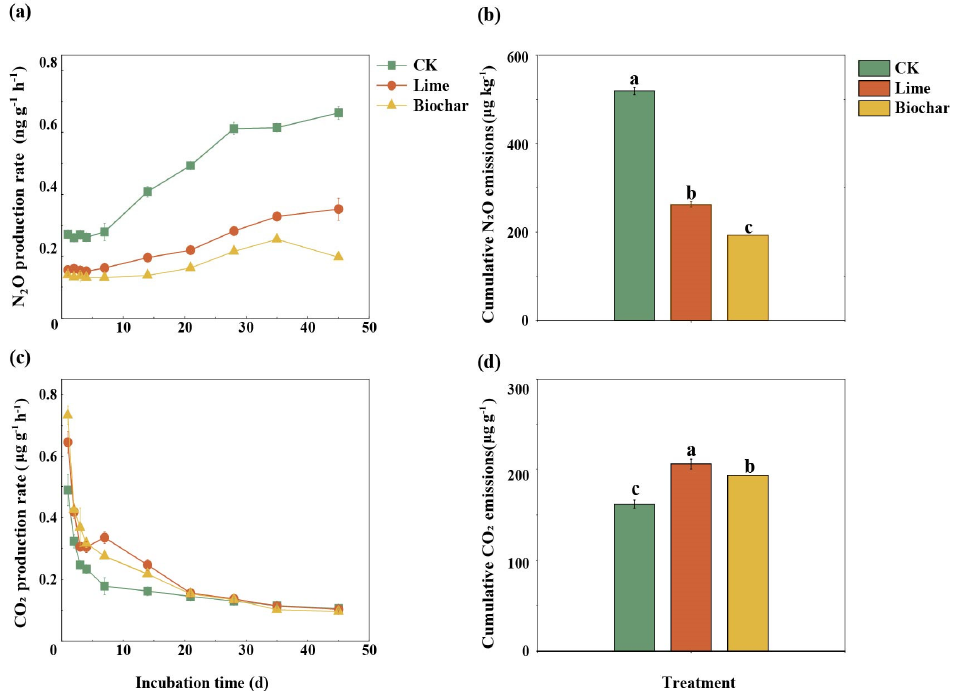
Figure 2. N 2 O ( a ) and CO 2 ( c ) emission rate and cumulative N 2 O ( b ) and CO 2 ( d ) emissions during the 45 − day incubation period for CK, lime, and biochar treatments. Error bars indicate standard deviations ( n = 3). Means followed by di ff erent le tt ers indicate signi fi cant di ff erences between treat- ments at p < 0.05.